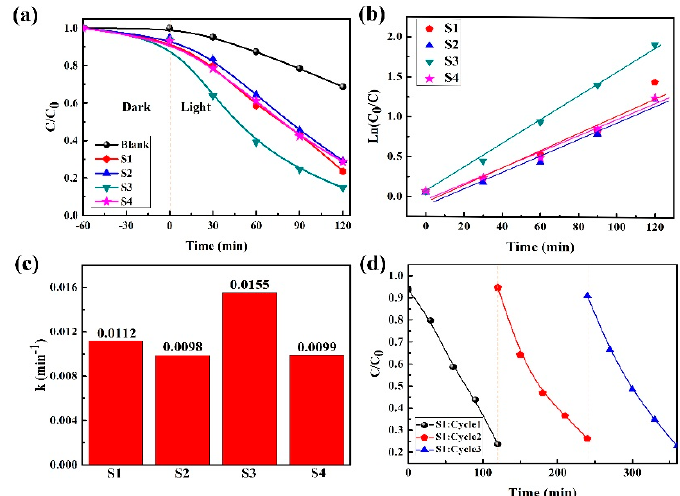
Figure 5. ( a ) Photocatalytic degradation of RhB with as-prepared samples under UV light irradiation. ( b ) The pseudo-first-order reaction kinetics for RhB degradation with the as-synthesized samples S1, S2, S3, and S4. ( c ) Kinetic constants for photocatalytic degradation of RhB. ( d ) Cycling experiments for sample S1 for RhB degradation.